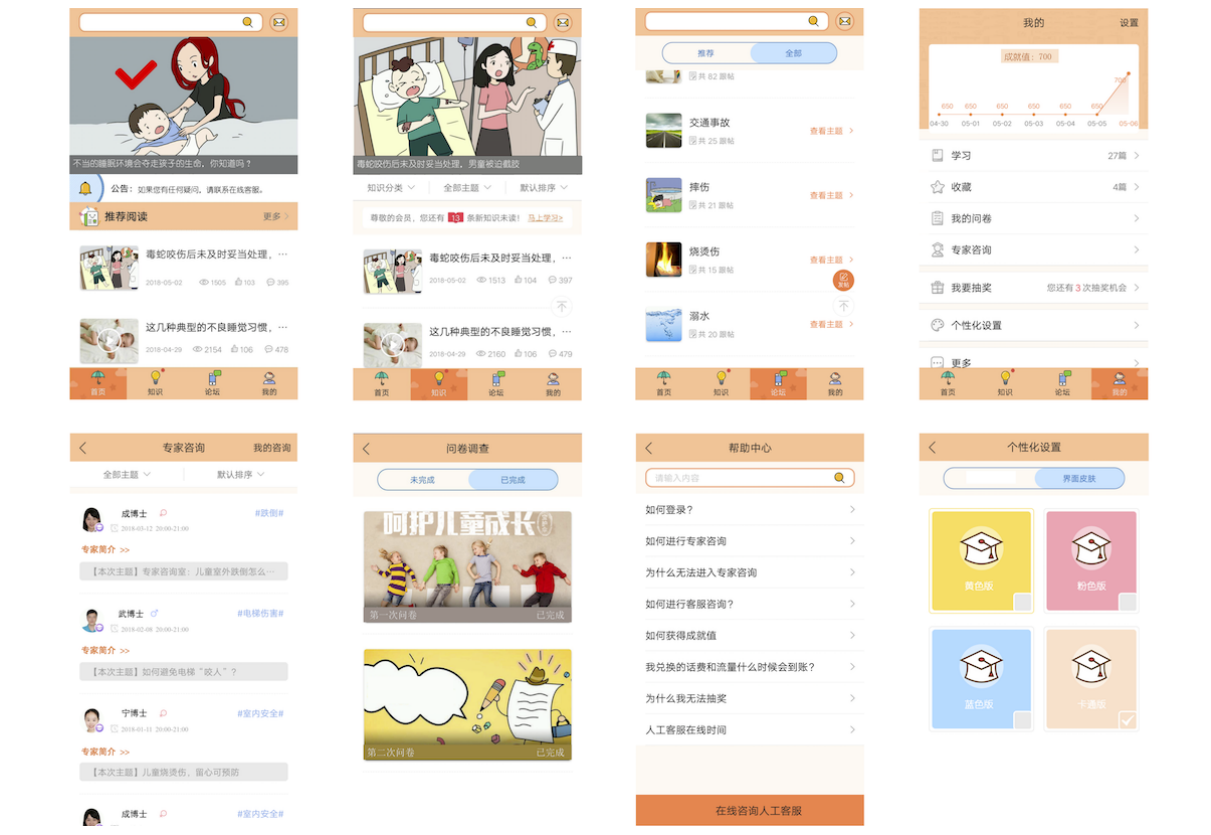
Figure 1. Home page of the app intervention. The app home page as translated into English appears in Figure MA3-1 in Multimedia Appendix 3. Eight images within the figure were derived from the app Bao Hu San, which was developed by the research team for unintentional injury prevention among preschool students and was tested in this